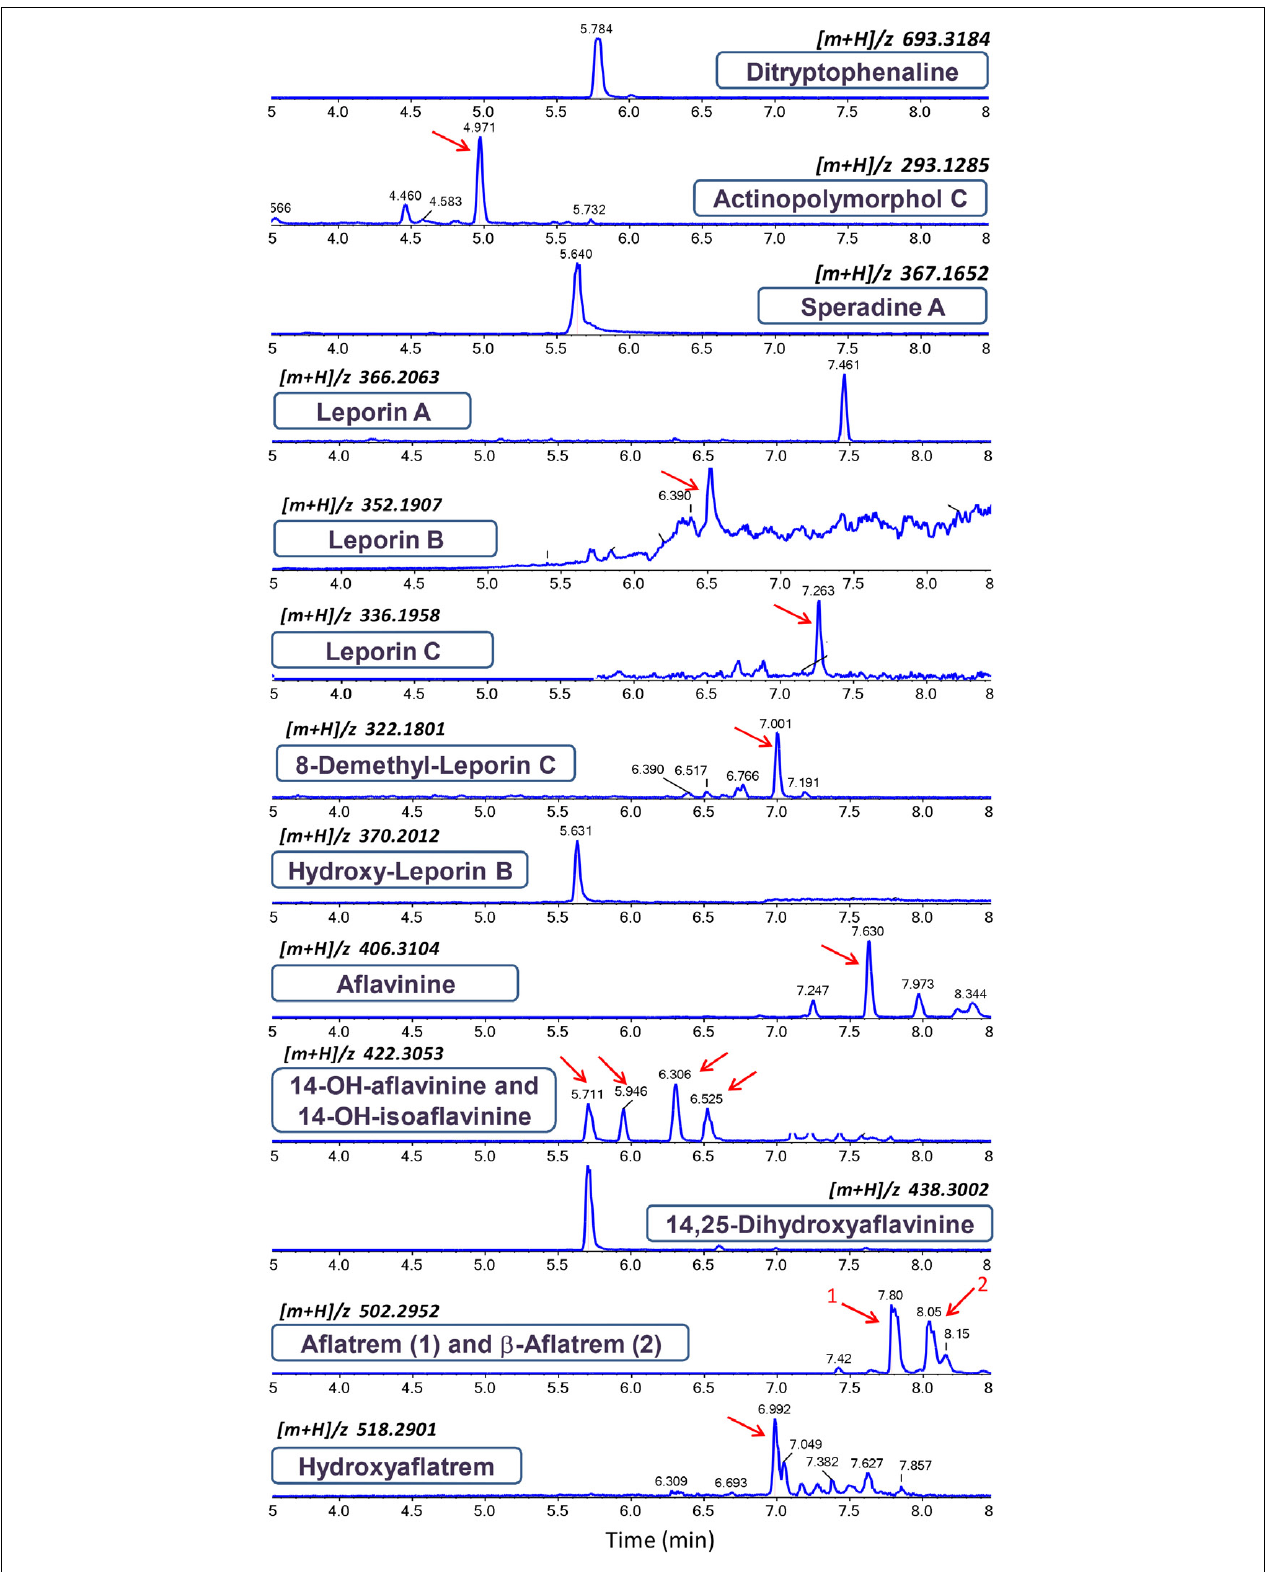
FIGURE 1 | Extracted ion chromatograms (EICs) and elution order of the Aspergillus flavus metabolites detected in this study. Red arrows indicate the correct retention time.